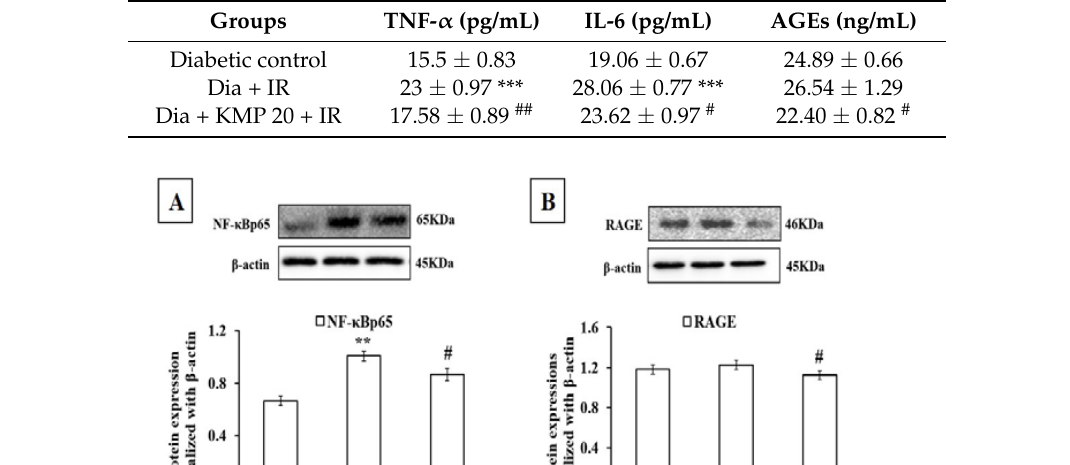
Table 4. Effect of kaempferol on serum tumor necrosis factor- α (TNF- α ), interleukin-6 (IL-6), and advanced glycation end products (AGEs) levels. TNF- α : tumor necrosis factor- α ; IL-6: interleukin-6;